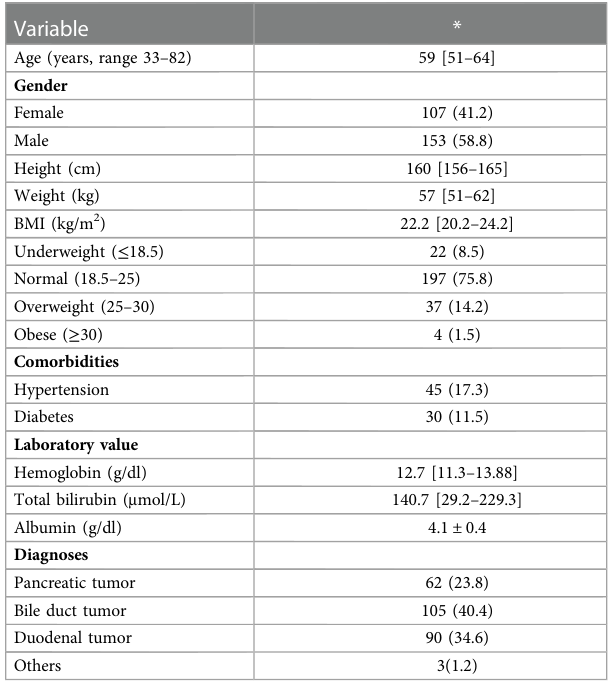
TABLE 1 Patient characteristics ( n =260).